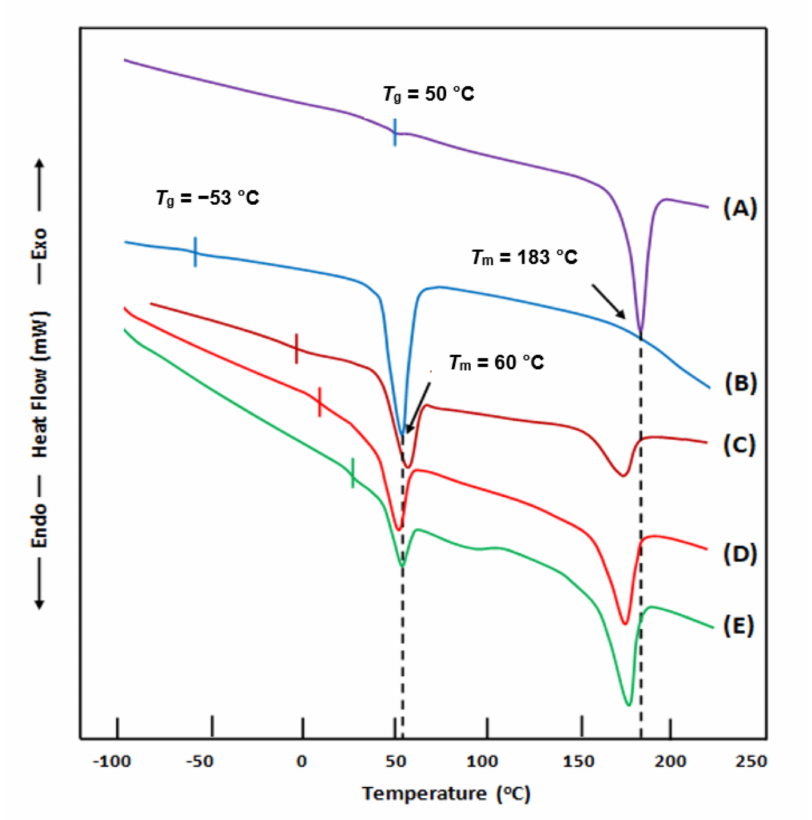
Figure 1. Differential scanning calorimetry (DSC) thermograms of ( A ) poly( δ -valerolactone) (PEVAL); ( B ) poly(ethylene-co-vinylalcohol) (PDVAL); ( C ) PEVAL/PDVAL blend; ( D ) PEVAL/PDVAL/ β - TCP70 composite; ( E ) PEVAL/PDVAL/ β -TCP50 composite. Here, β -TCP70 and β -TCP50 represent 70 and 50 wt% of beta-tricalcium